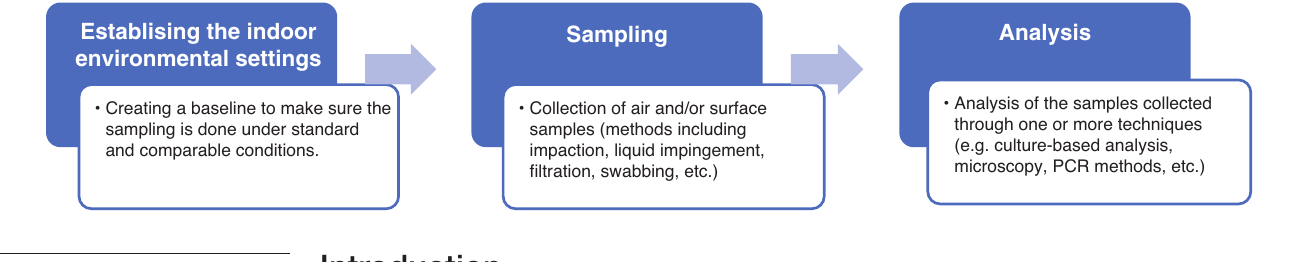
Schematic representation of the main stages of indoor fungal testing. (Source: Authors, 2022.)